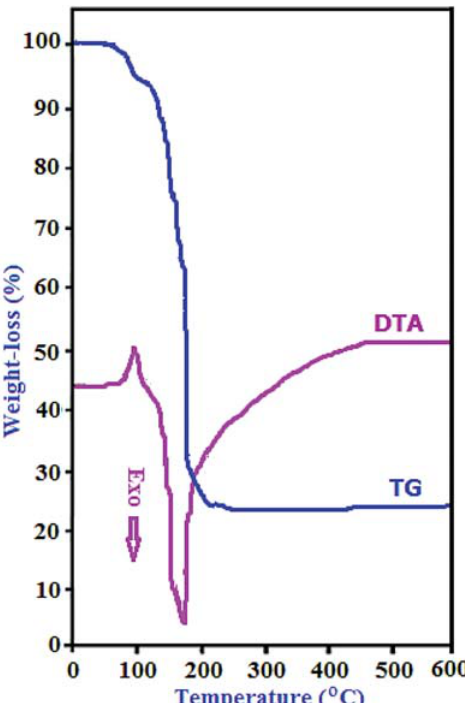
) (H O) ] (NO ) com- 3 5 2 3 3